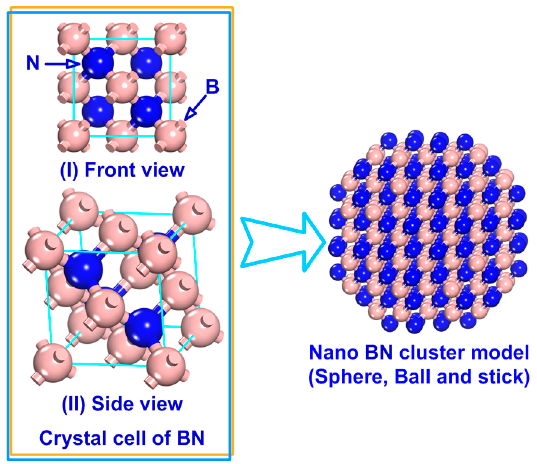
Figure 12. The molecular model of nano-BN.